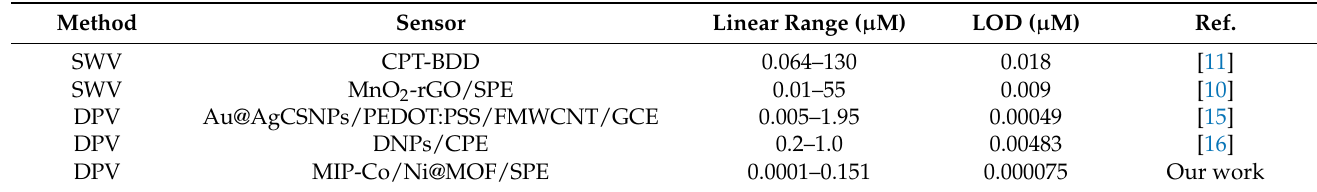
Table 1. Comparison of MIP-Co/Ni@MOF/SPE with reported electrochemical